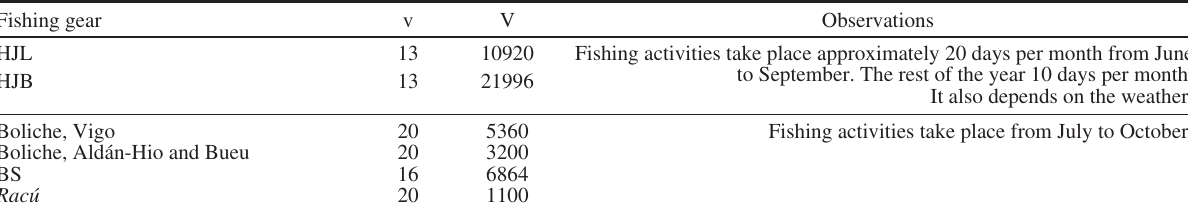
Table 4. – Average number of fishing trips per month per boat (v) and average number of trips made by the whole (V) by fishing gear. HJL, hand-jig from land; HJB, hand-jig from boat; Boliche, beach seine; BS, boat seine. Fishing gear v